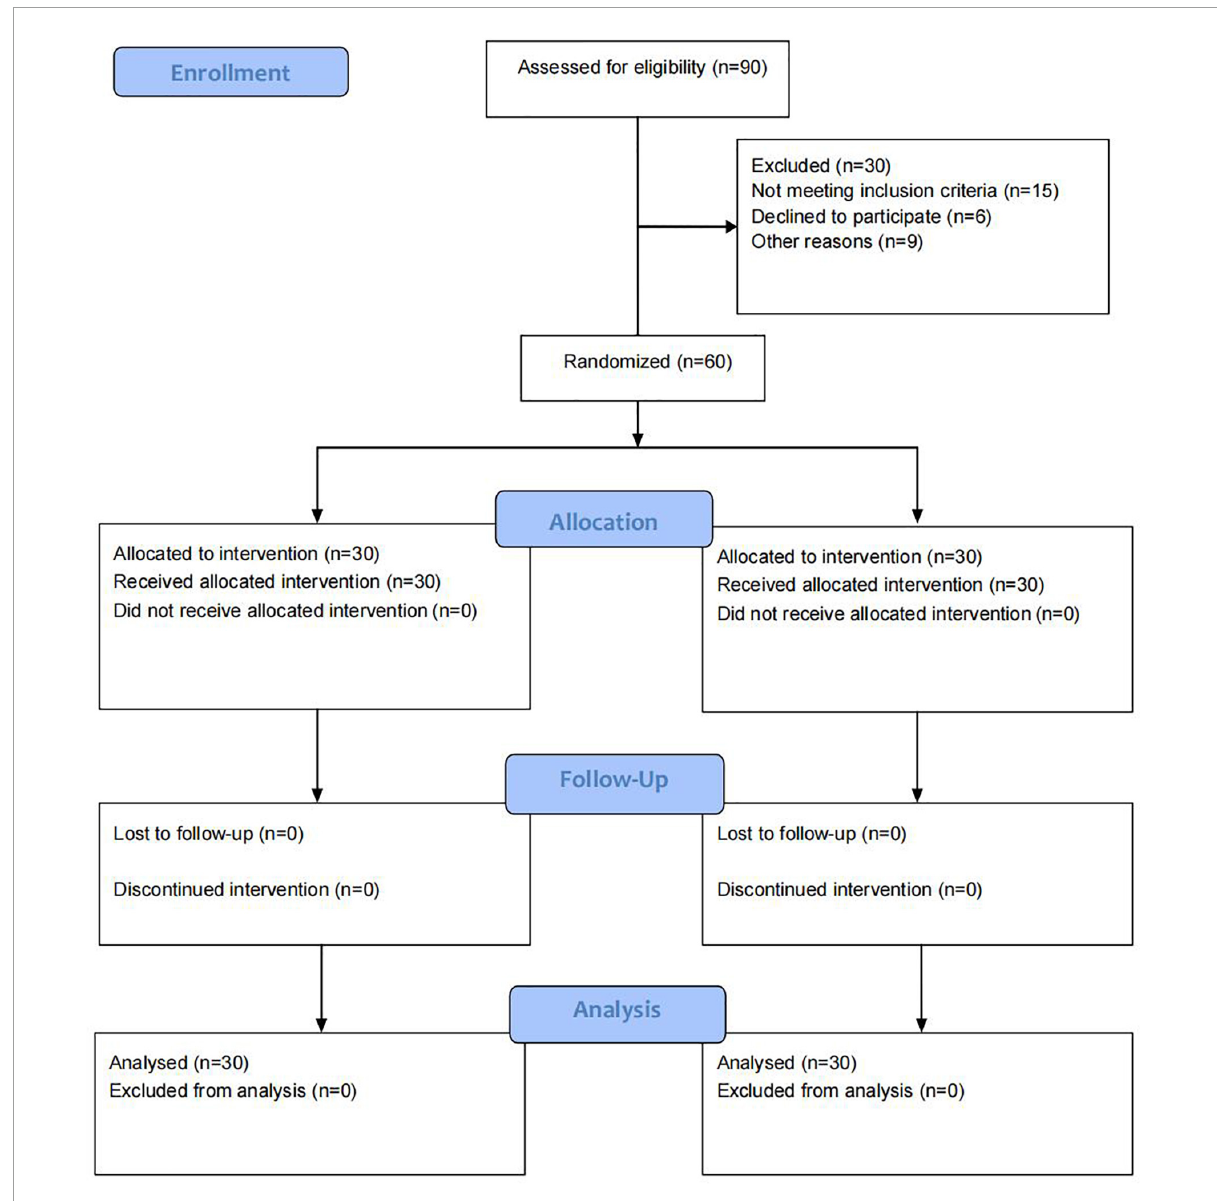
FIGURE3 Recruiting process